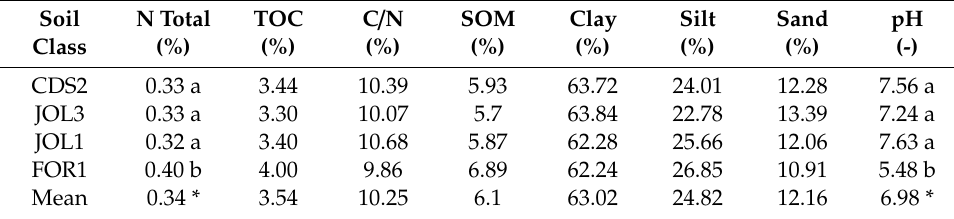
Table 5. Results of the soil sampling carried out in the experimental